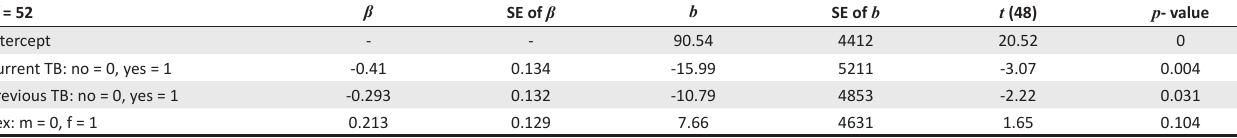
TABLE 3: FVC % predicted regressional analysis with 3 outliers removed and forward stepwise analysis. N = 52 β SE of β